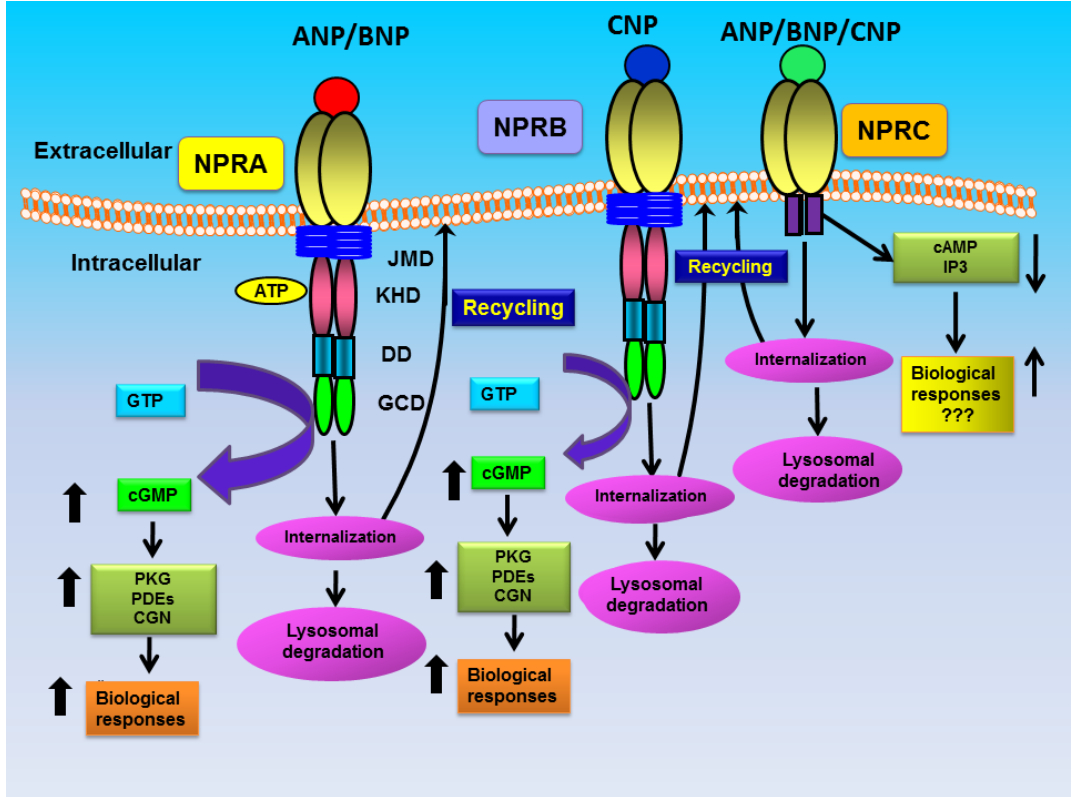
Figure 1. Diagrammatic representation of ligand-dependent activation and post-binding events of NPRA, NPRB, and NPRC: ANP binding activates NPRA, which leads to enhanced production of second messenger cGMP. The bound ligand-receptor complexes of NPRA are internalized into the intracellular compartments and a large proportion of ligand-bound receptors are degraded in the lysosomal compartments, while a small population of internalized receptors recycles back to the plasma membrane. An increased accumulation of intracellular cGMP activates cGMP-dependent protein kinase (PKG), which plays a critical role in ANP-dependent biological responsiveness. The second messenger, cGMP can also activate phosphodiesterases (PDEs) as well as cGMP-gated ion channels to activate ANP-dependent cellular and physiological functions. CNP activates NPRB, which is also internalized, degraded in lysosomes, and recycled back to the cell surface. Ligand- binding to NPRC is suggested to lower cyclic adenosine 3',5'-monophosphate (cAMP) levels and to increase inositoltrisphosphate (IP 3 ) in target cells. The bound ligand-receptor complexes of NPRC are internalized, degraded in the lysosomal compartments, and recycle back to the membrane [35] JMD, juxtamembrane domain; KHD, kinase like homology domain; DD, dimerization domain; GCD, guanylyl cyclase catalytic